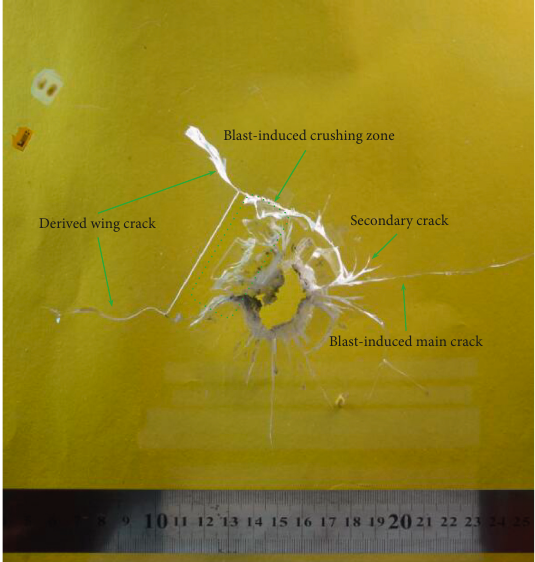
Figure 23: Blasting effect drawing for case SN